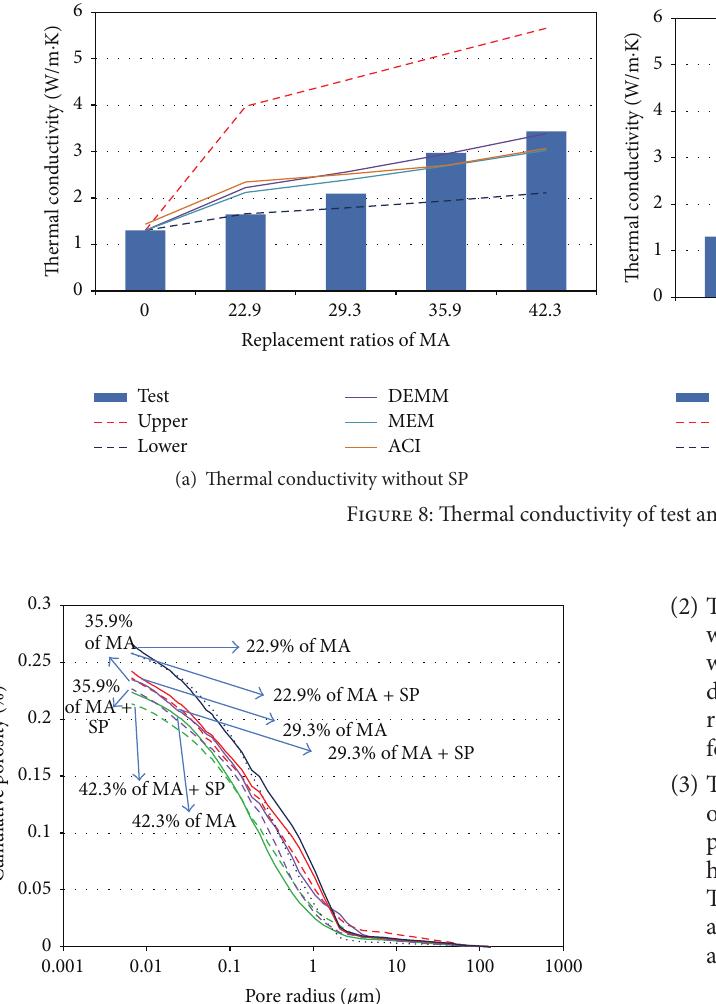
Figure 9: Reduced porosity with increasing MA and SP.